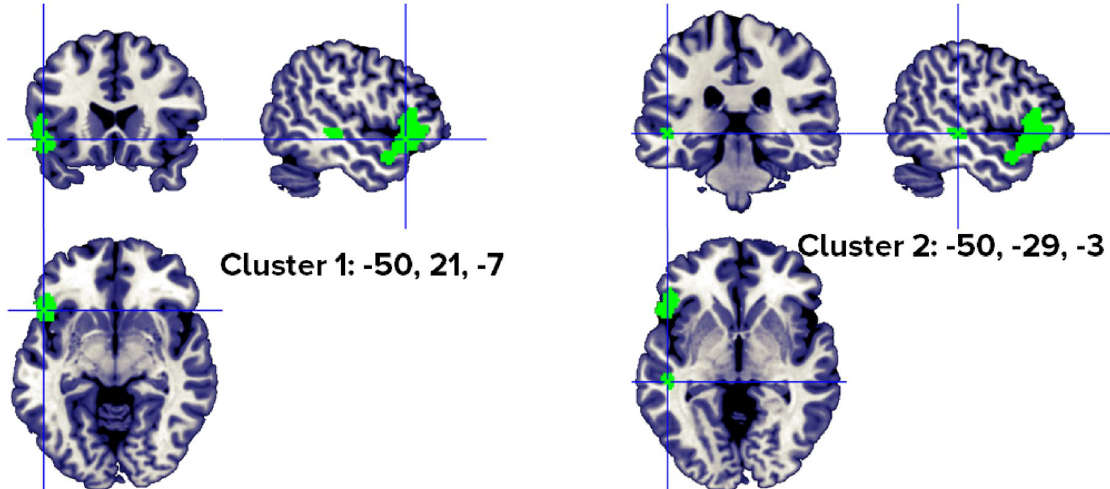
Figure 9. Clusters activated by the abstract > concrete words -semantic and lexical task- contrast. The crosses are centered in the areas correspond to stereotactic coordinates reported in Table 9. The images are presented in neurological